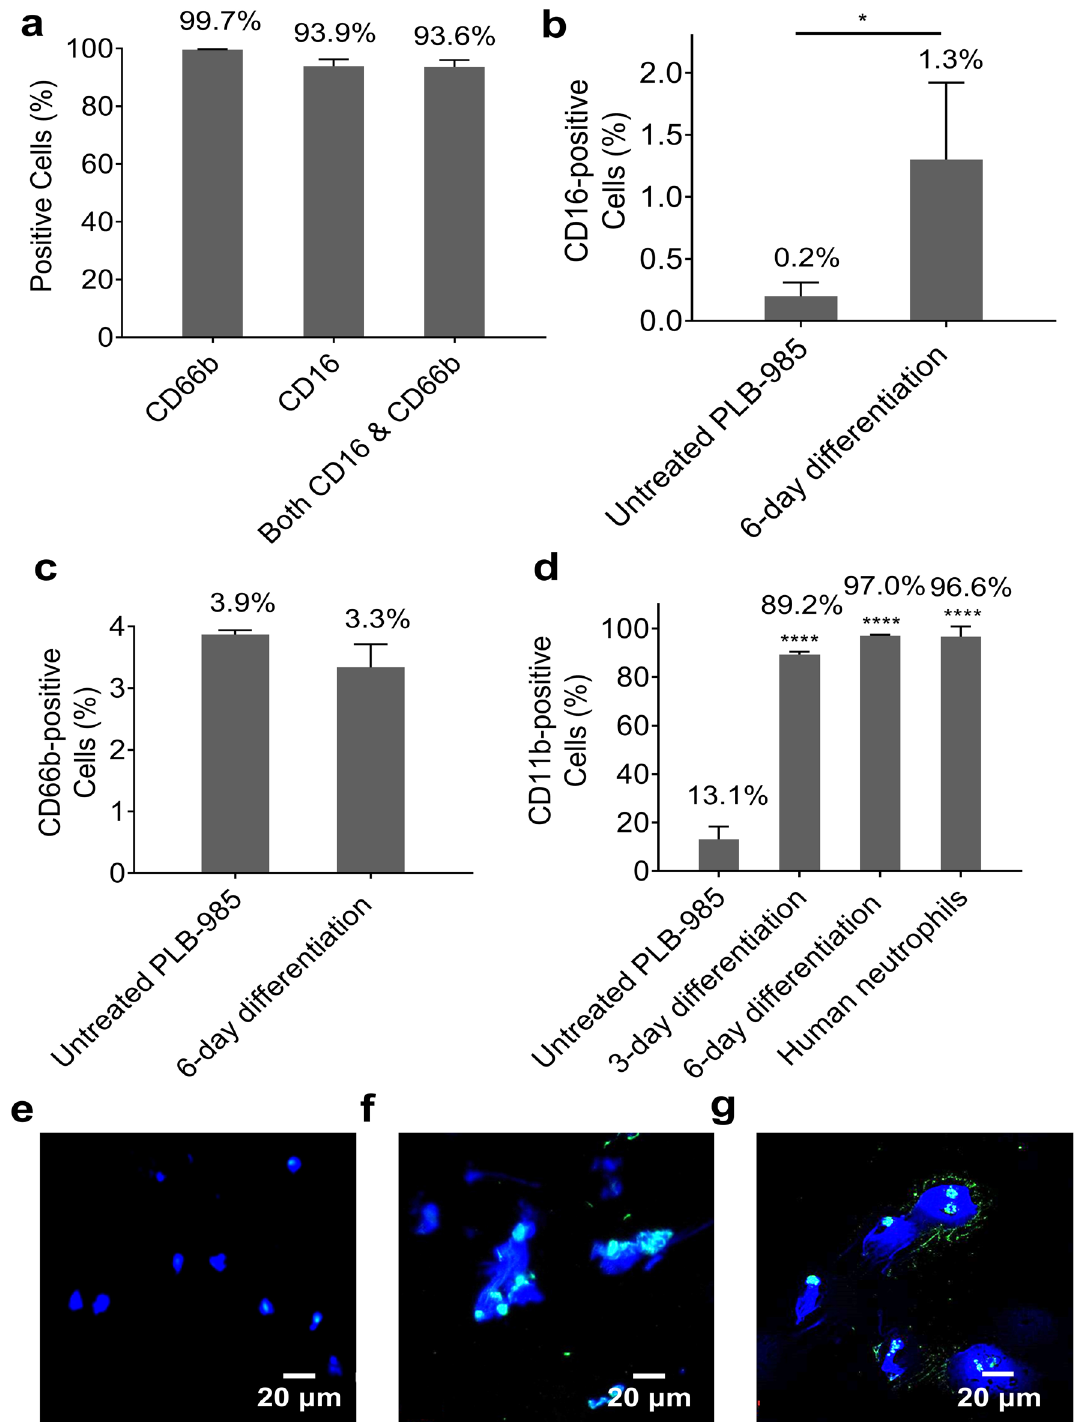
Figure 1. Expression of neutrophil-surface antigens on isolated human neutrophils and differentiated PLB-985 cells and the capacity of NETosis of these cells. The expression of antigens on cells was detected in living cells via flow cytometry. ( a ) Expression levels of CD16 and CD66b on human neutrophils were used as the positive control. Expression levels of ( b ) CD16 and ( c ) CD66b on differentiated PLB-985 cells were detected on the day 6 of treatment with 1.25% DMSO, untreated cells were used as the negative control. ( d ) Expression level of CD11b on differentiated PLB-985 cells was detected on the day 3 and day 6 of treatment with 1.25% DMSO, untreated PLB-985 cells were used as a negative control, and human neutrophils were used as a positive control. Error bars represent SD of three technical replicates. * P < 0.05, **** P < 0.0001. ( e ) Unstimulated human neutrophils using fluorescence microscopy. ( f ) NETs generated from isolated human neutrophils stimluated with PMA. ( g ) NETs generated from differentiated PLB-985 cells stimulated with PMA. Blue: DAPI-stained DNA. Green (cyan in overlay with blue): Alexa Fluor 488 labelled Histone H3 (citrulline R2 + R8 +